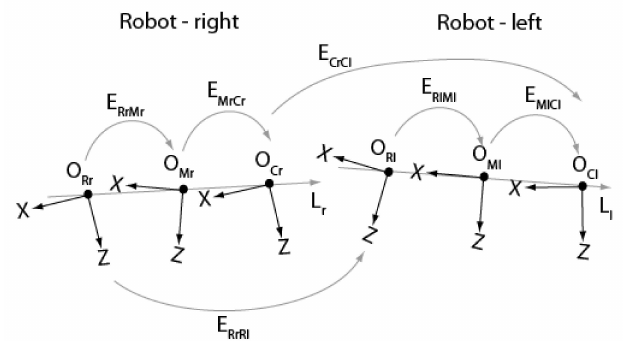
Figure 4. The geometric model of the ASP showing the reference frames describing the stereo setup as well as the transformations between frames. The Z -axis of all frames points towards the page. The linear translation stages are represented by Lines L r ( right ) and L l ( left ).